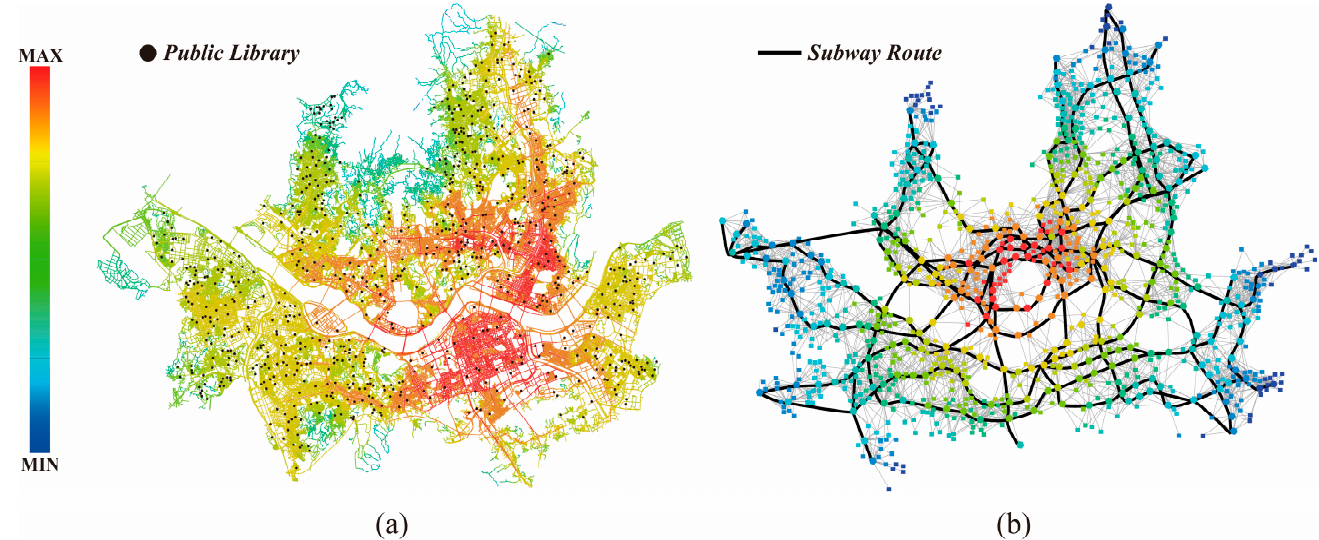
Figure 7. The integration of public libraries in Seoul: ( a ) axial map integration graph; ( b ) convex space integration graph.